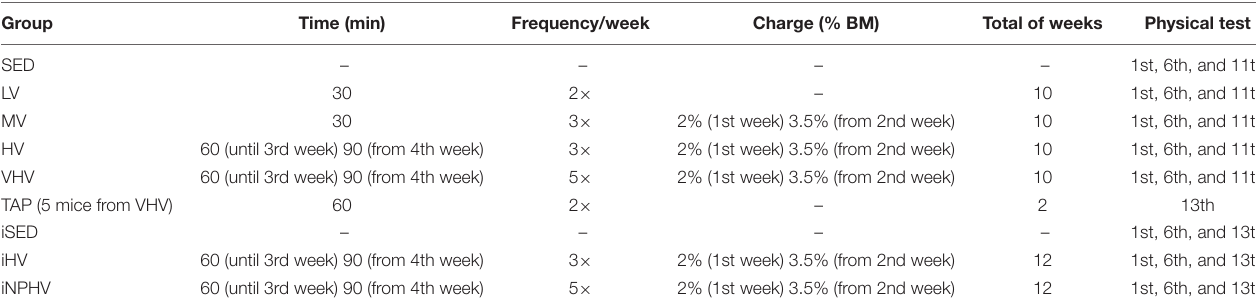
TABLE 1 | Swimming exercise protocol data of the experimental cohorts.